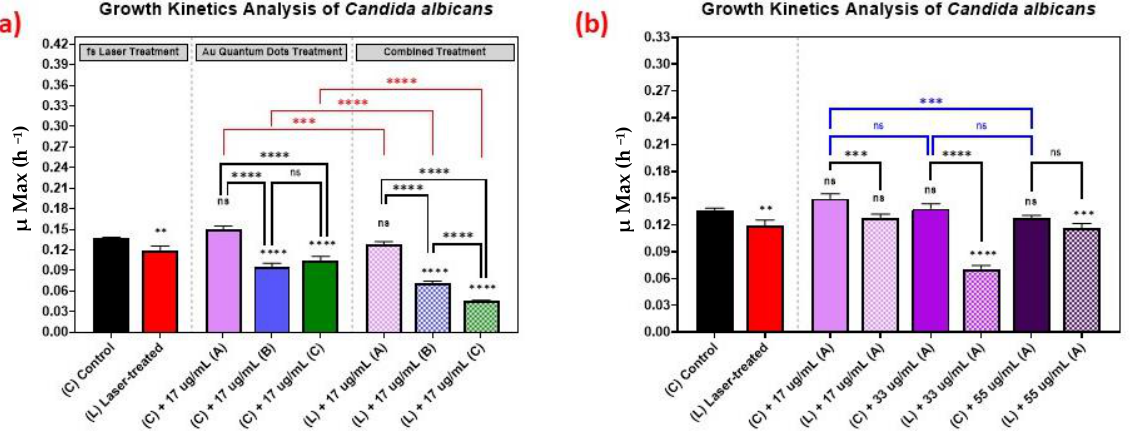
Figure 7. Growth analysis of Candida albicans , comparing the control culture (N) to the laser-treated (L), AuQDs-treated (N + A, B, or C), and laser + AuQDs-treated (L + A, B, or C) cultures. Sample (A) (7.8 nm average size), sample (B) (8.7 nm average size), and (C) (11.6 nm average size). ( a ) Bar graph comparing the growth rate during the log phase of the control culture (N) with that of the bacterial cultures exposed to different treatments, where the AuQD treatment was carried out using three samples: sample (A), sample (B) and sample (C) at the same concentration of 17 µg/mL. ( b ) Bar graph comparing the growth rate during the log phase of the control culture (N) with that of the bacterial cultures exposed to different treatments, where the AuQD treatment was carried out using sample (A) with concentrations of 55, 33, and 17 µg/mL. Significance was tested by ANOVA followed by Tukey testing (**** p < 0.0001, *** p < 0.001, ** p < 0.01, ns; no significance).